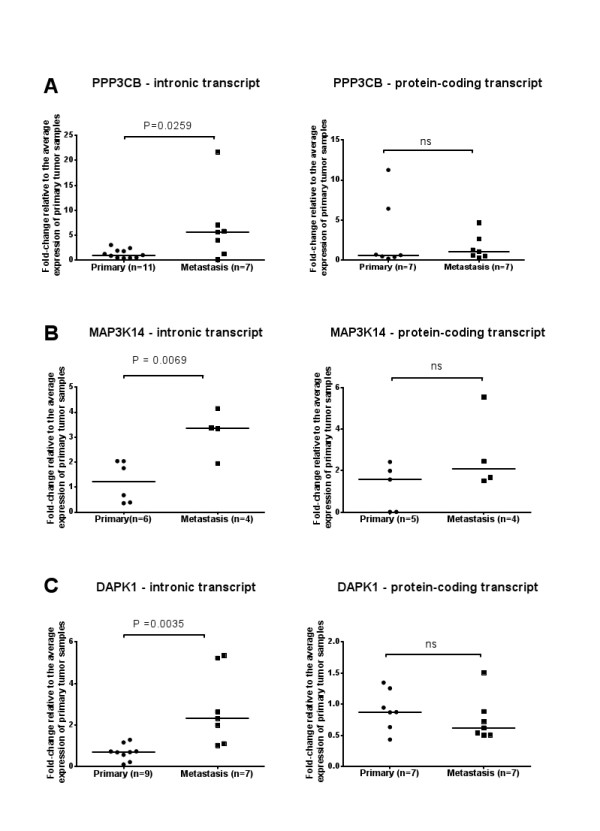
Expression changes of intronic lncRNAs mapping to PPP3CB, MAP3K14 and DAPK1 loci are not accompanied by changes in the corresponding protein-coding mRNAs. Relative levels of intronic lncRNAs and protein-coding mRNAs from PPP3CB (A), MAP3K14 (B) and DAPK1 (C) loci were determined by Real-Time PCR in clinical samples of primary adenocarcinoma (circles) or distant metastasis (squares) from pancreatic cancer patients. For each transcript, the number of tested samples is indicated in the × axis. For each gene, results are expressed as fold-change relative to the average expression of primary tumor samples. For each sample, qPCR assays were performed in triplicate and mean values are shown. House-keeping gene HMBS was used as the endogenous control for normalization across patient samples. All intronic transcripts (left panels) were differentially expressed in metastatic samples at a significance threshold of p< 0.05 (PPP3CB, p = 0.0259; MAP3K14, p = 0.0069; DAPK1, p = 0.0035). Protein-coding transcripts (right panels) were not significantly differentially expressed.